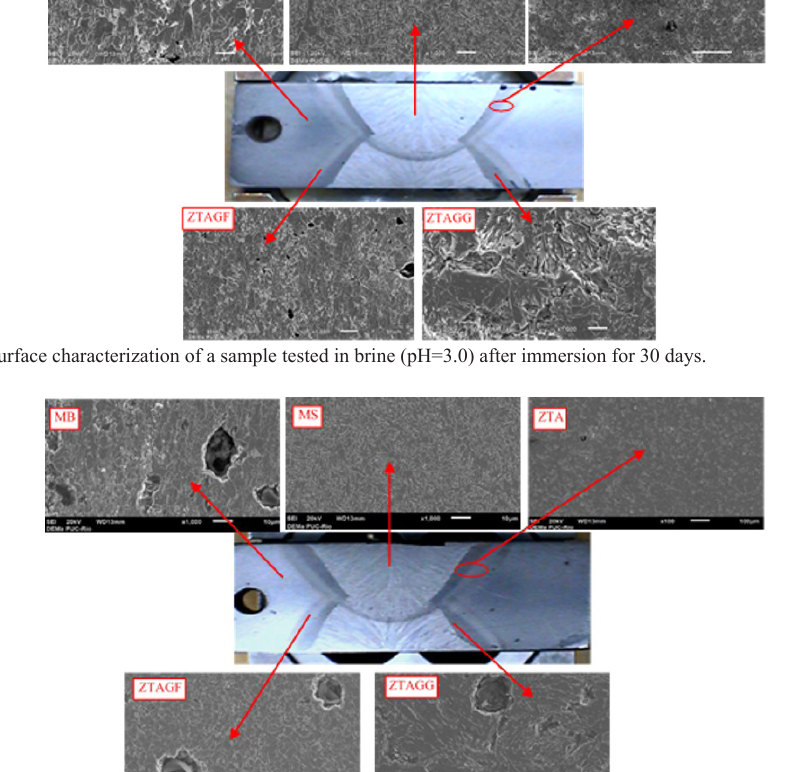
Figure 7. SEM surface characterization of the sample after 30 days immersion at solution 1 (10 -3 mol/L Na